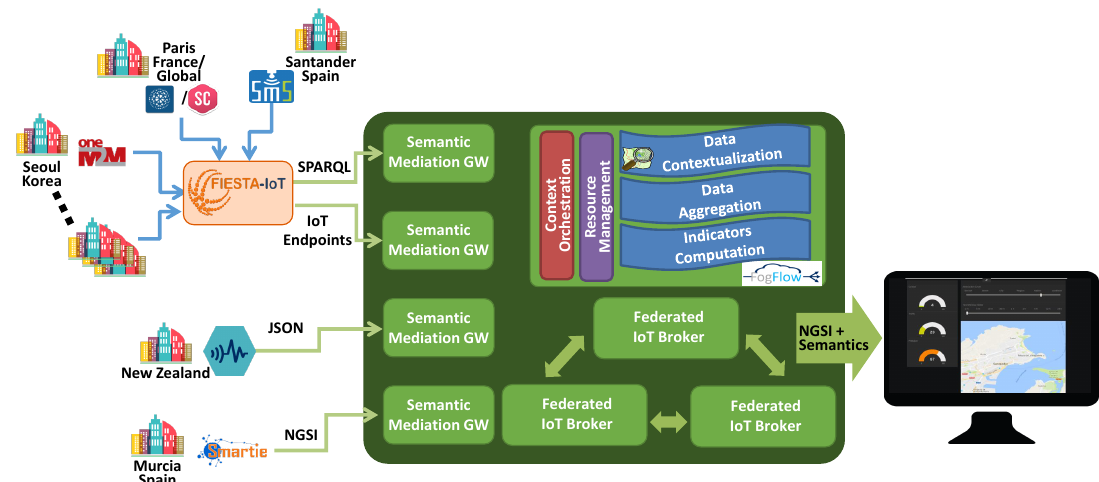
Figure 6. Realization of the Smart-City Magnifier application leveraging semantic mediation , semantic interoperability , resource orchestration and federation of IoT platforms